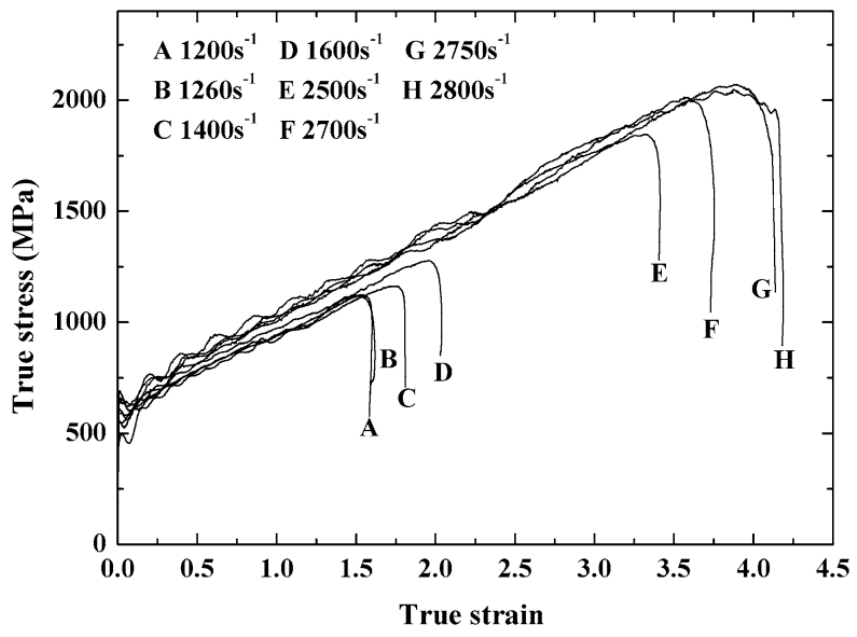
Figure 39. Compressive true stress–strain curves of the CoCrFeMnNi HEA at loading rates that varied from 1200 to 2800 s − 1 (reproduced from Reference [166] with permission).